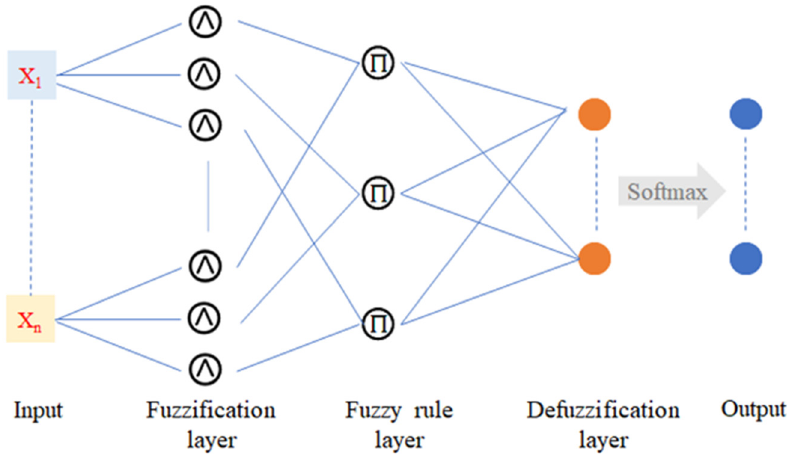
Figure 4. Architecture of an FNN.